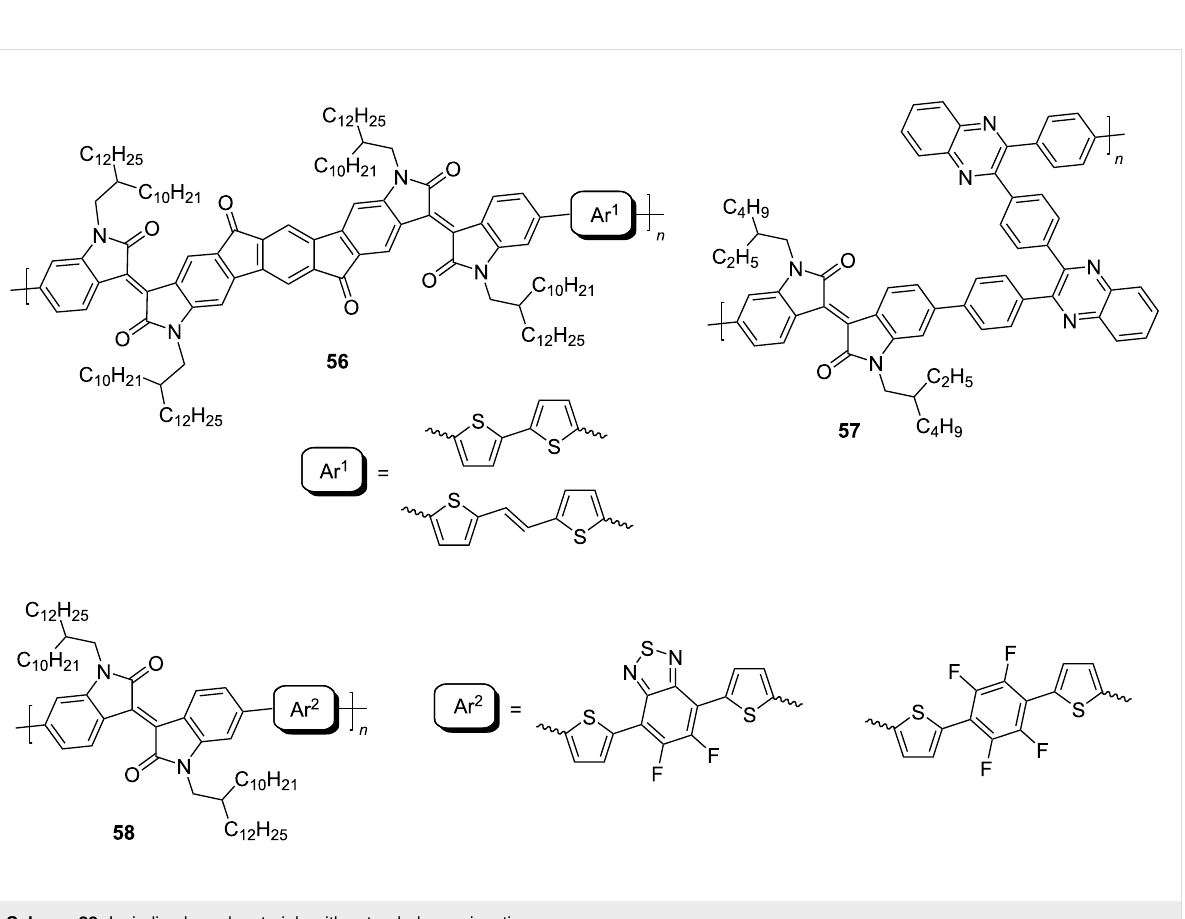
Scheme 28: Isoindigo-based materials with extended π